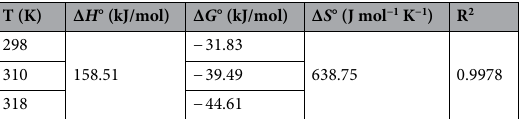
Table 3. Thermodynamic parameters of MBZ-BSA Interaction at pH 7.4.